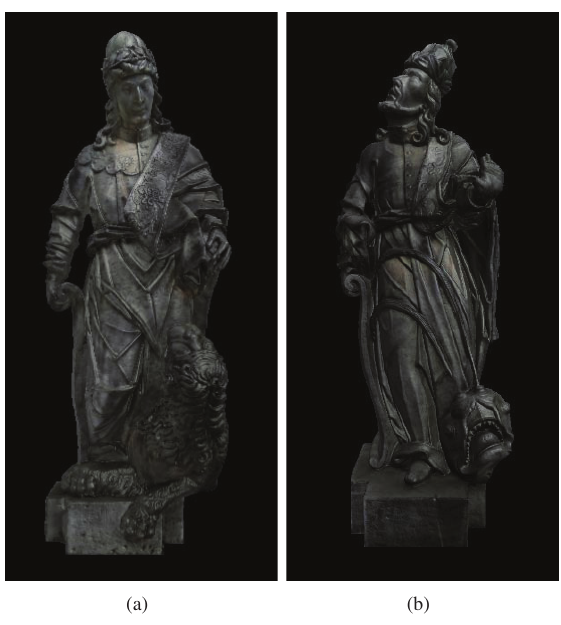
Fig. 4. Rendered 3D models of two preserved Prophets: (a) Prophet Daniel and (b) Prophet